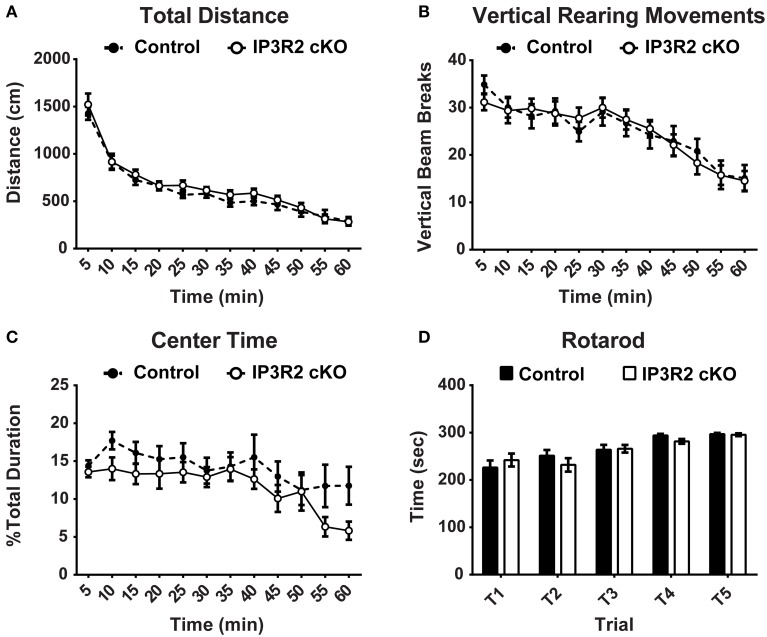
Motor function and exploratory behavior are unaffected in the IP3R2 cKO. (A,B) Spontaneous locomotor activity and exploratory behavior measured in the open field activity task was unaffected in the IP3R2 cKO. IP3R2 cKO (clear circles, n = 26) mice were not significantly different (p = 0.43) from control mice (black circles, n = 26) in spontaneous motor activity measured by total distance in open field testing or vertical rearing movements. (C) Anxiety measured by percentage of time spent in or moving through the center of the activity box was also not significantly different (p = 0.14). (D) Motor coordination and learning over a 2-day, 5 trial testing period using an accelerating rotarod was not significantly different (p = 0.70) between IP3R2 cKO (clear bars, n = 26) and control animals (black bars, n = 26).